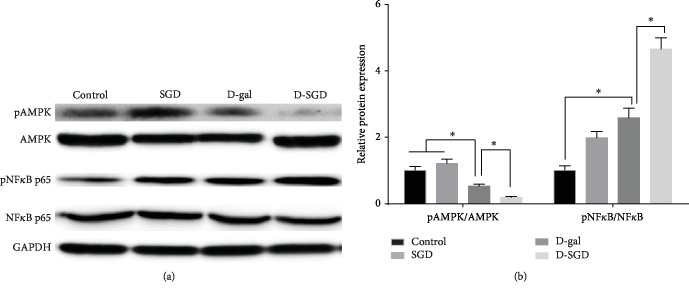
Effects of serine deficiency on AMPK and NFκB expression in D-galactose-treated mice. (a) Protein expression of AMPK, pAMPK, NFκB p65, and pNFκB p65; (b) Relative expression of pAMPK and pNFκB p65 according to the results of (a). Data were expressed as mean ± SEM, n = 3. ∗P < 0.05.